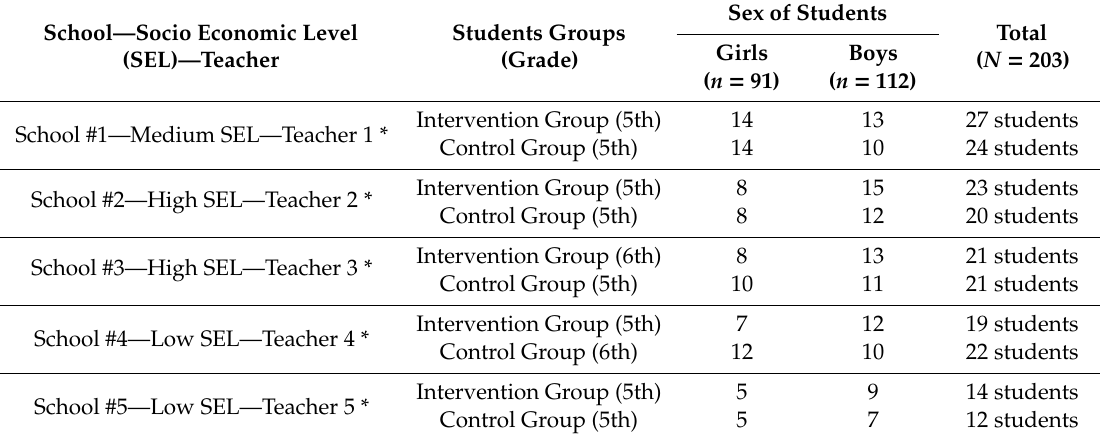
Table 1. Students, Teachers and School Characteristics Involved in the